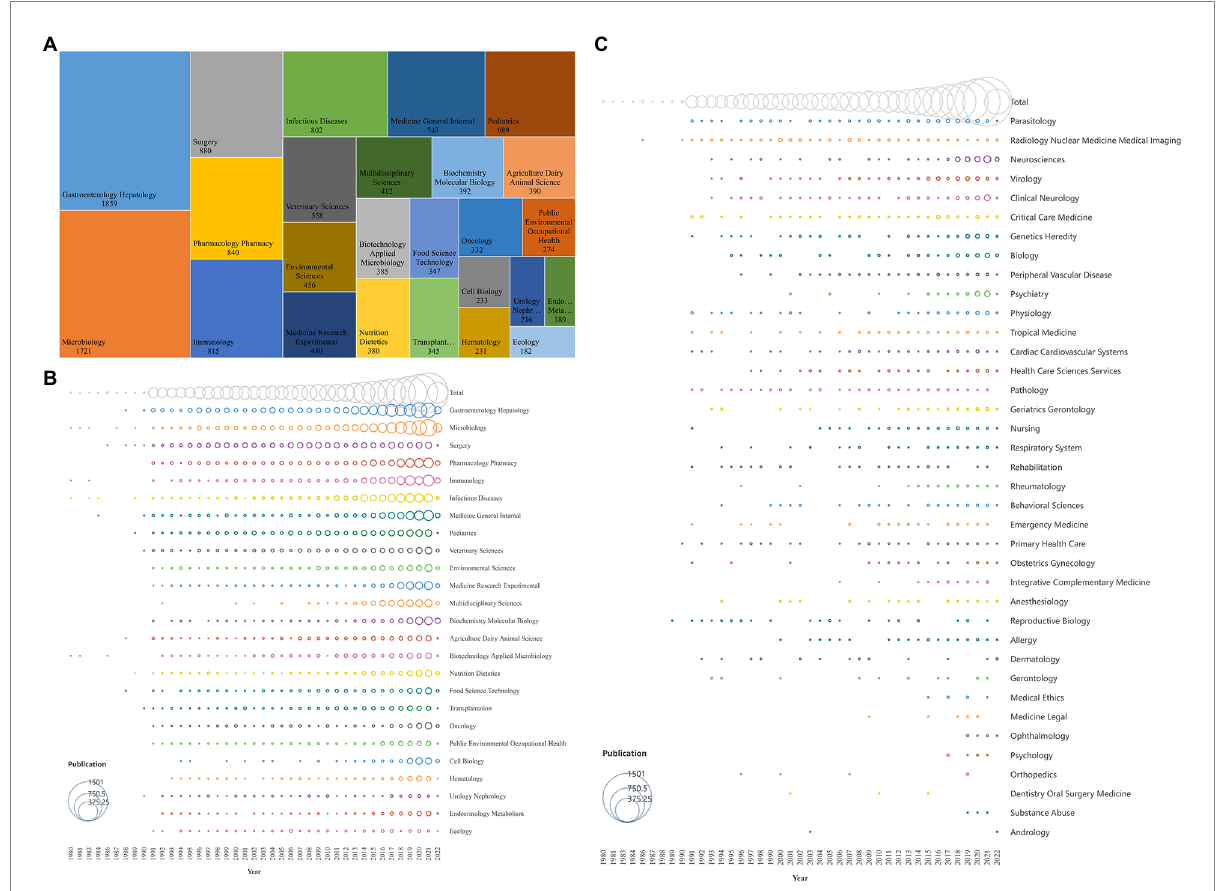
FIGURE 3 The Web of Science categories and the trend of their annual publications. (A) Top 25 categories of publication about FMT. (B) Annual publications and trend of the top 25 categories. (C) Annual publications and trend of other categories related to clinical medicine. The size of the circle represents the number of annual publications in each